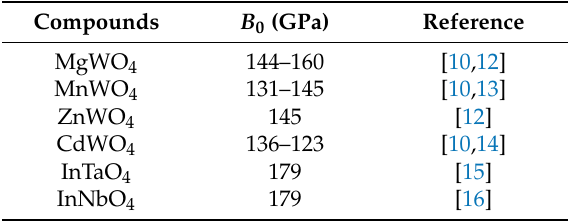
Table 1. Experimental bulk modulus ( B 0 ) of different wolframites. Results were obtained from [10] and